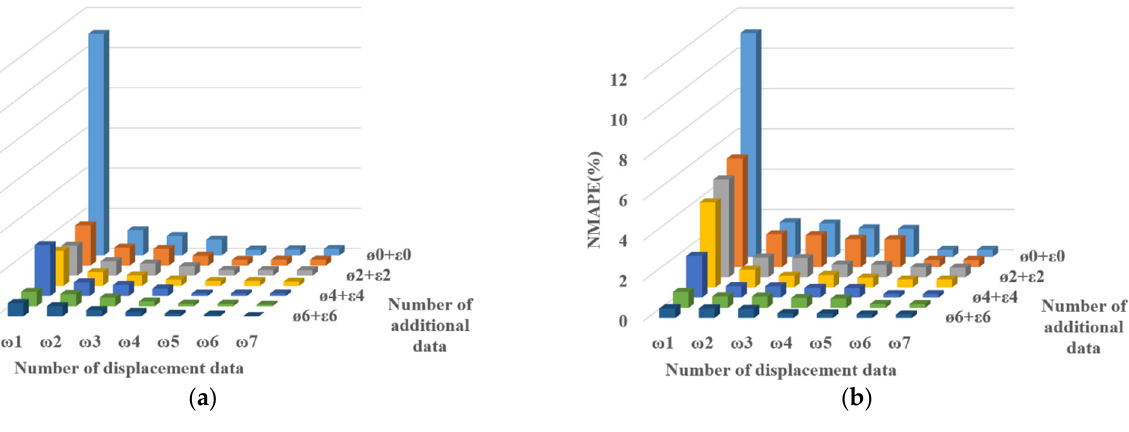
( d ) Figure 7. NMAPE of the EDS according to the number of measurement data. ( a ) TM1; ( b ) TM2; ( c ) TM3; ( d ) TM4. Figure 8. Example of EDS for TM4. 5.2. Internal Force The displacement value at a certain point of the structure has generally been used to indirectly evaluate the performance of a structure by comparing it with a limited standard displacement. Therefore, most studies have focused on the estimation of displacement at a certain point, such as the girder center, using other response data. However, if internal forces such as axial force and moment can be estimated, the performance of the structure can be more precisely evaluated by comparing the internal force with the section strength. Based on the stiffness method, the internal force of the structure can be derived using displacement and rotation. The internal forces of each element were determined by using